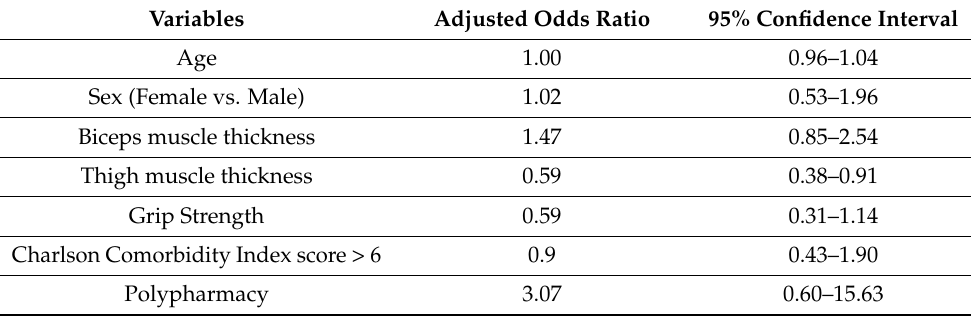
Table 4. Multiple logistic